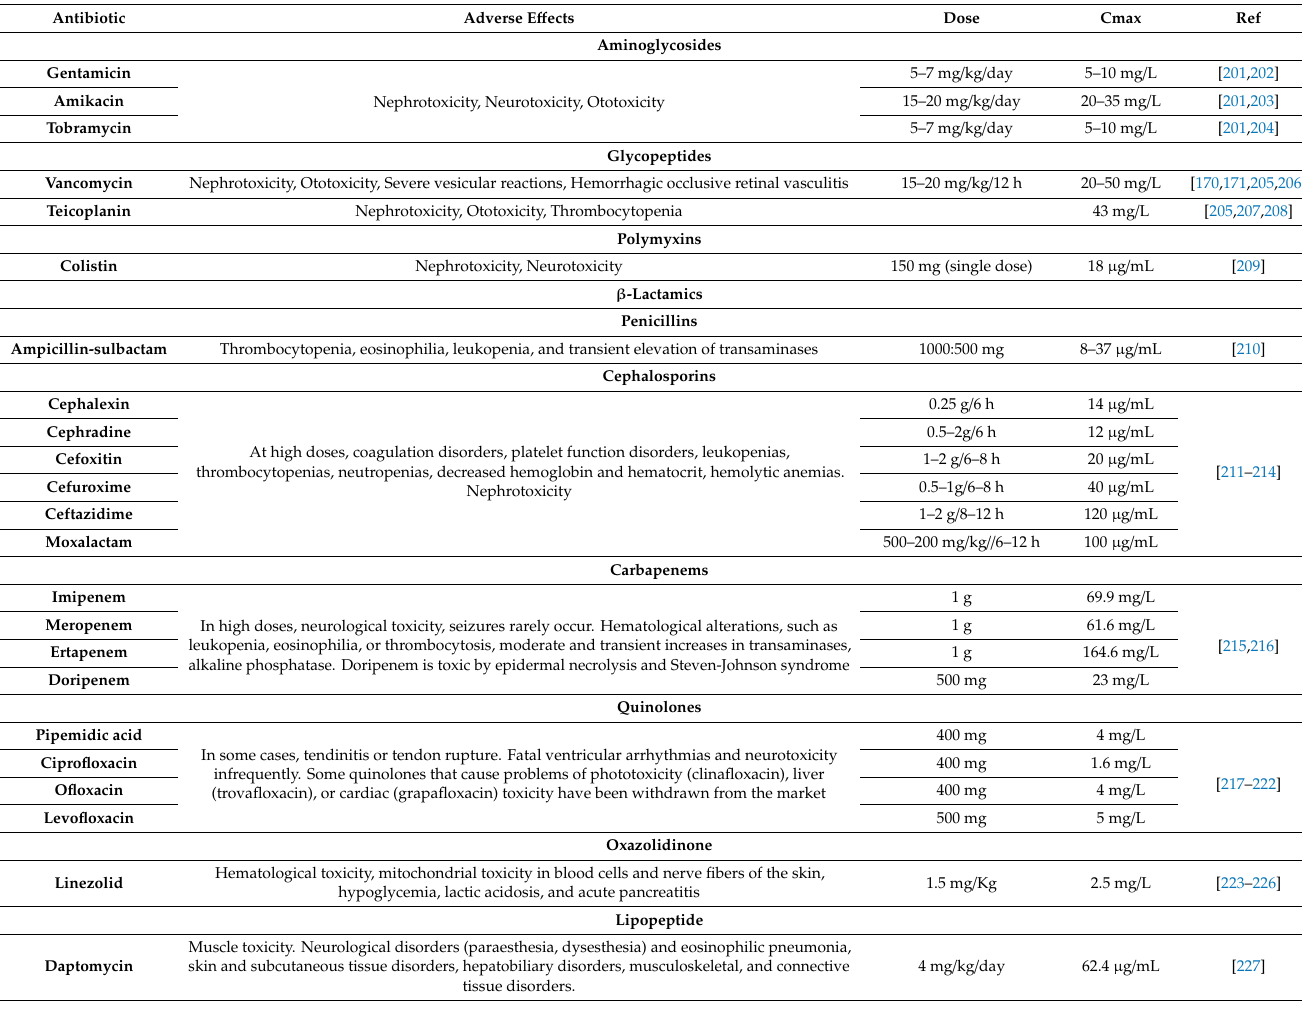
Table 2. Dose and maximum concentration (Cmax) of antibiotics (AB) that according to the pharmacokinetic (PK) characteristics require therapeutic drug monitoring